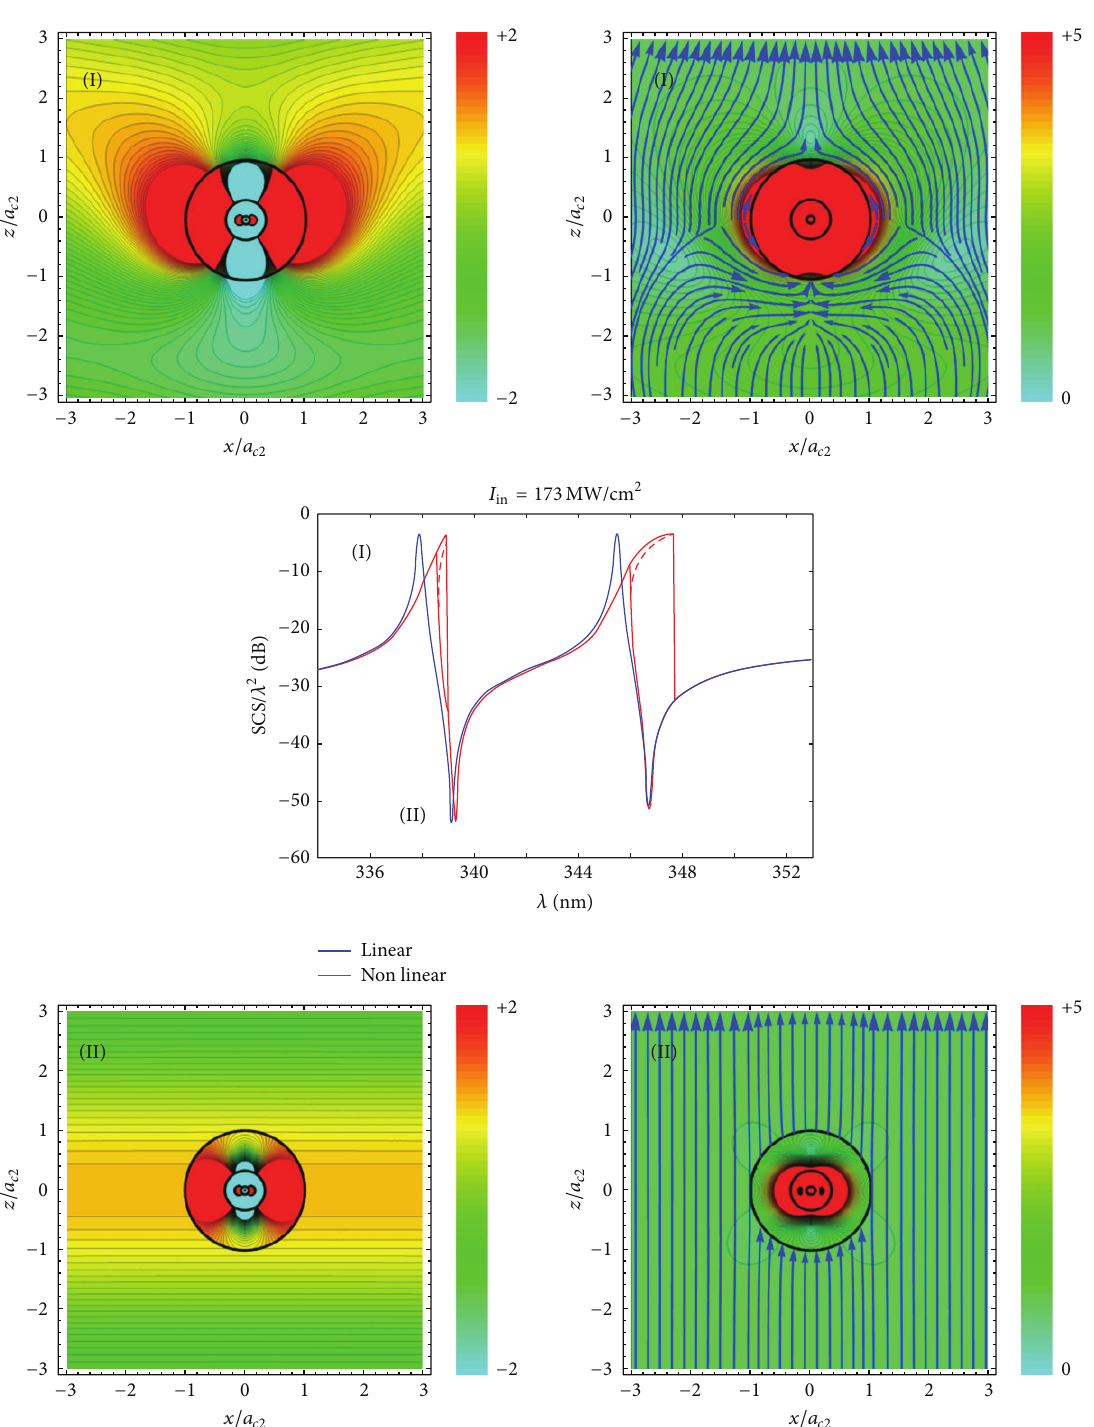
Figure 4: Normalized scattering response versus wavelength, for linear (blue line) and nonlinear (red line) dielectric core for the geometry in Figure 1(a). The electric field (left insets) and power flow (right insets) distributions are plotted on the 𝐸 plane at the higher-frequency Fano-like resonant peak (I) and cloaking dip (II) when linear operation is considered. The nonlinear plasmonic nanoparticle is illuminated = 173 MW / cm 2 . The unstable branch of the nonlinear bistable response is plotted with a dashed red with input intensity 𝐼 in